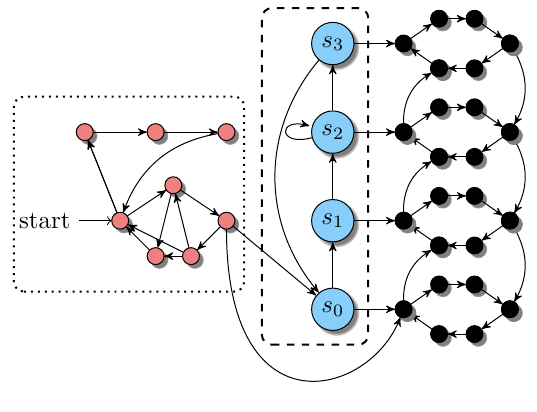
Figure 5: Dynamic State Deflection design methodology example. The original FSM (dashed blue part) is augmented by an HARPOON obfuscation mode (dotted red part) and each original state is protected by a black hole (states marked in